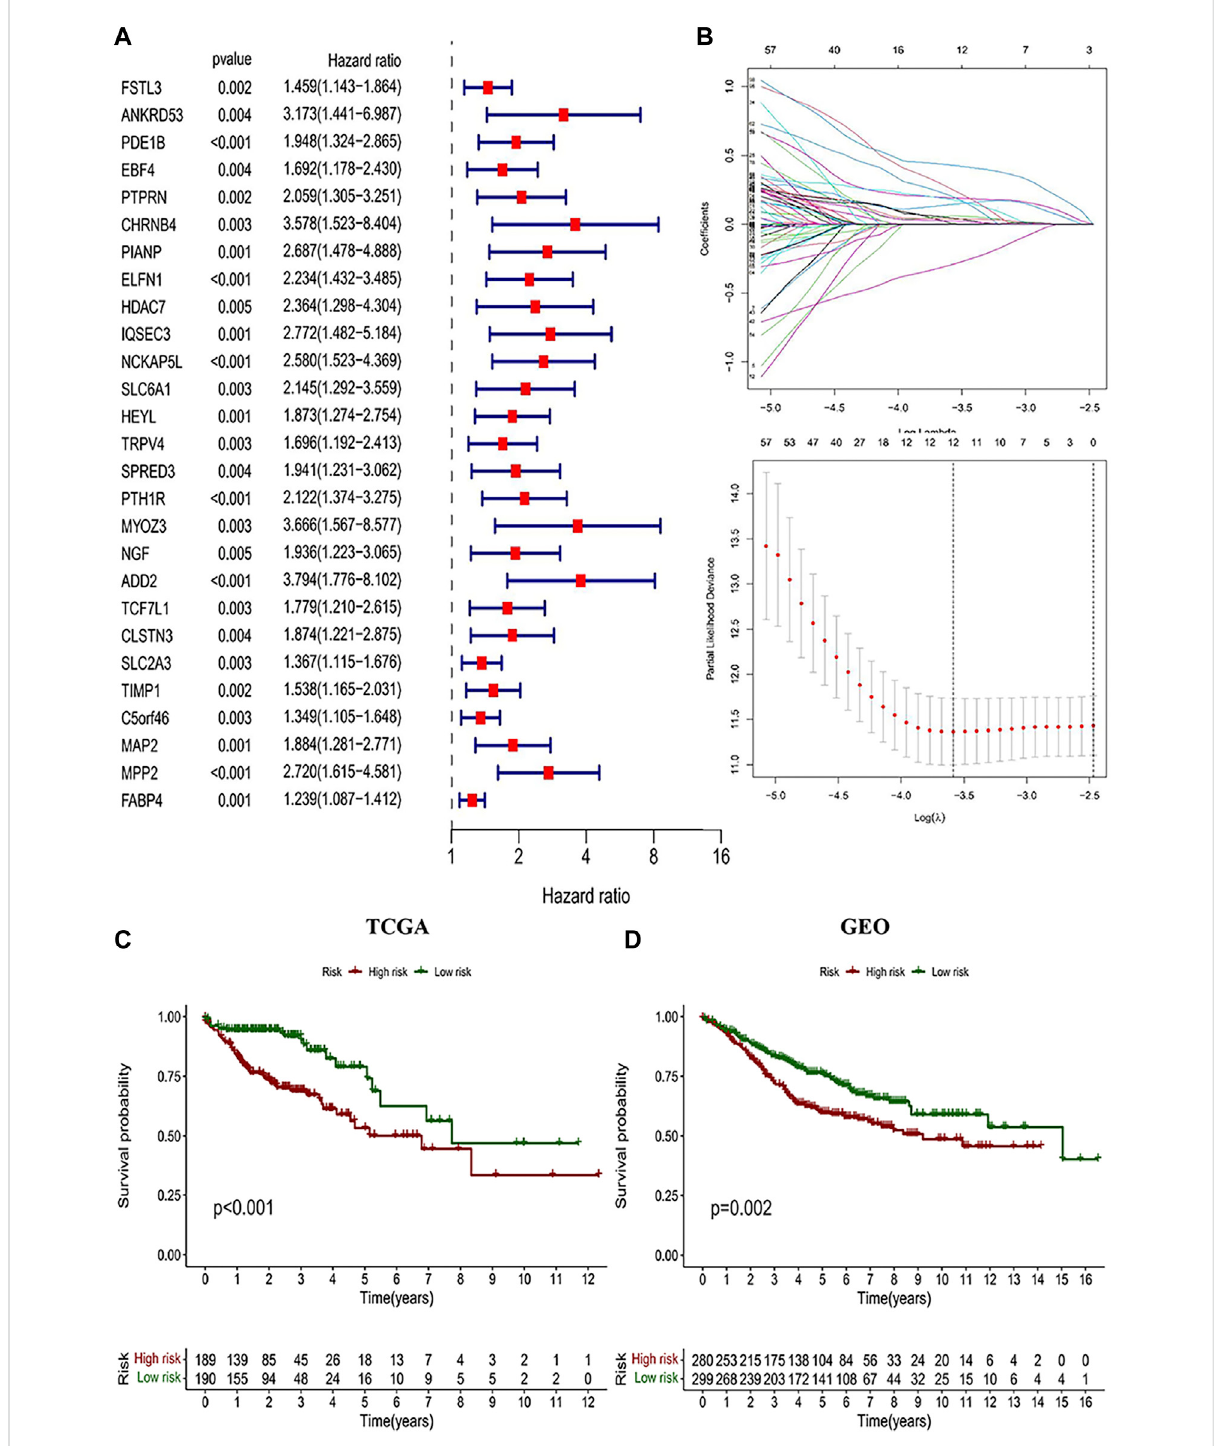
FIGURE 4 Identi fi cation of CD4 + MTC-related DEGs and construction of the prognosis model. (A) Univariate Cox regression analysis result of 103 prognosis-related genes in the study (27 genes with p < 0.005 were preferentially displayed). (B) Lasso regression and cross-validation showed that the number of genes corresponding to the point with the smallest error was 13. (C) COAD patients with low risk in the prognostic model predicted better OS outcomes. (D) GEO testing setwas used for validation, and theresults wereconsistent with thoseof theprognostic